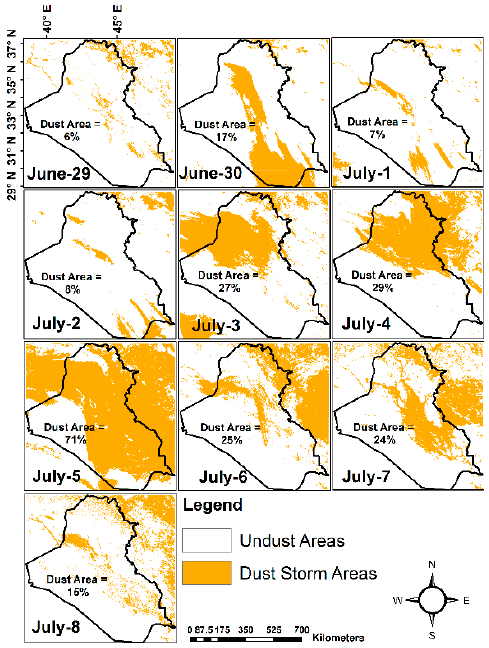
Figure 3. Shows the extraction of the percentage of dust storm areas; clouds, water bodies and other ground features are